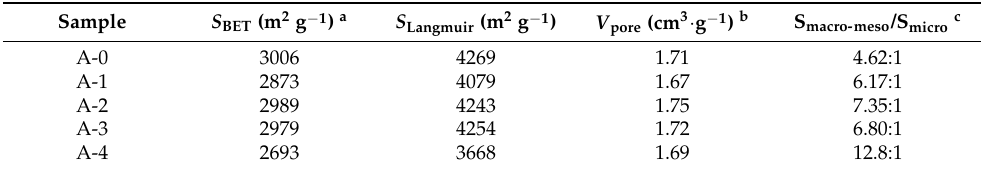
Table 1. The pore structure information of each